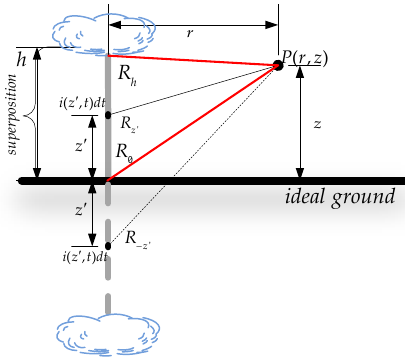
Figure 2. Model for calculating the lightning electromagnetic field.